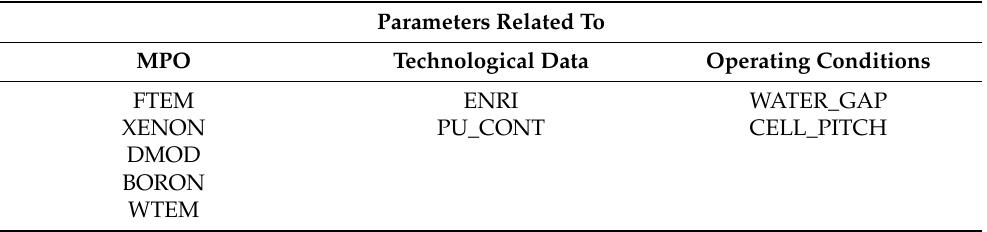
Table 5. 32 FA PWR minicore: simplified reflectors models description (see Figure